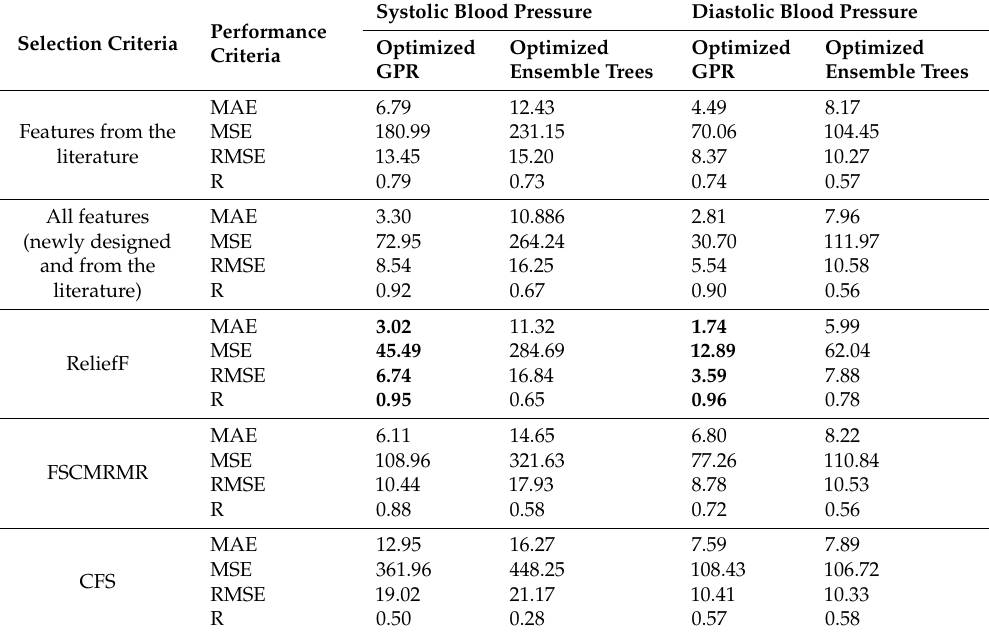
Table 11. Evaluation of the outperforming algorithms for estimating SBP and DBP after optimization.